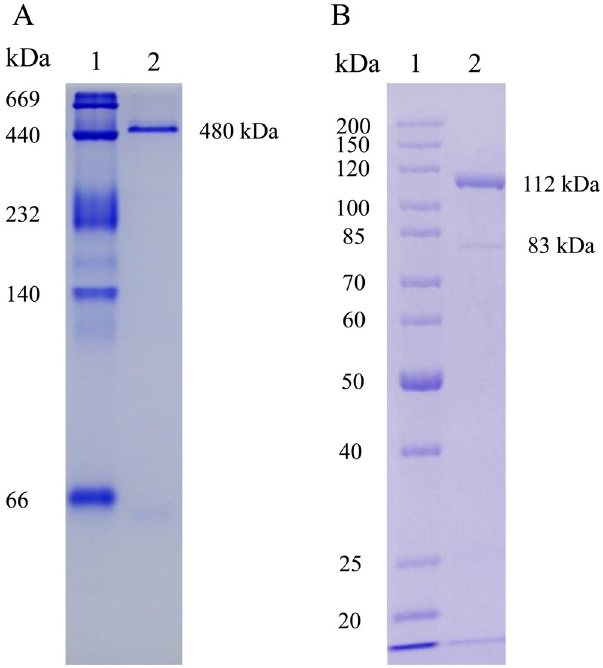
Figure 5. Native PAGE (4–7.5%) ( A ) and SDS-PAGE ( B ) electrophoretic patterns of purified guppy Lv. lane 1, protein maker; lane 2, the purified